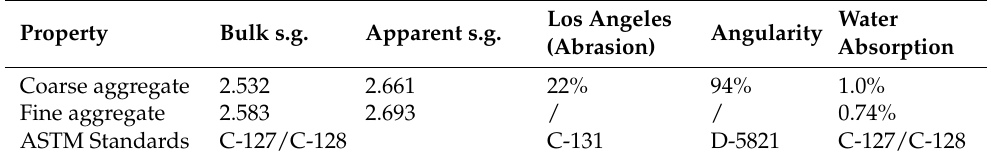
Table 4. Physical characteristics of the aggregate.